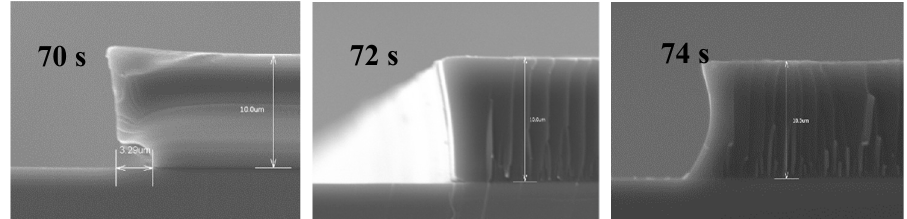
Figure 8. The SEM of different sidewall profile with the exposure time. Insufficient exposure time (70 s); moderated exposure time (72 s); the overexposure (74 s).